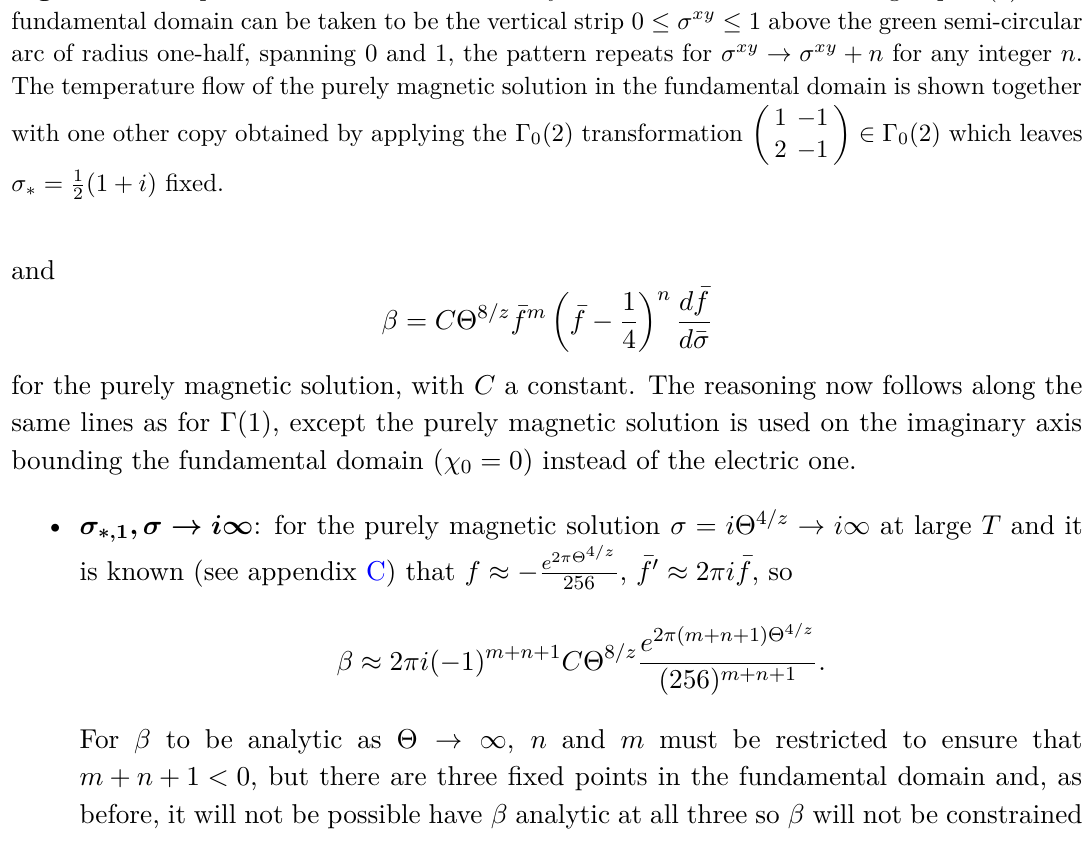
(cid:18) 1 − 1 (cid:19) (2) transformation ∈ Γ 0 (2) which leaves 0 2 − 1